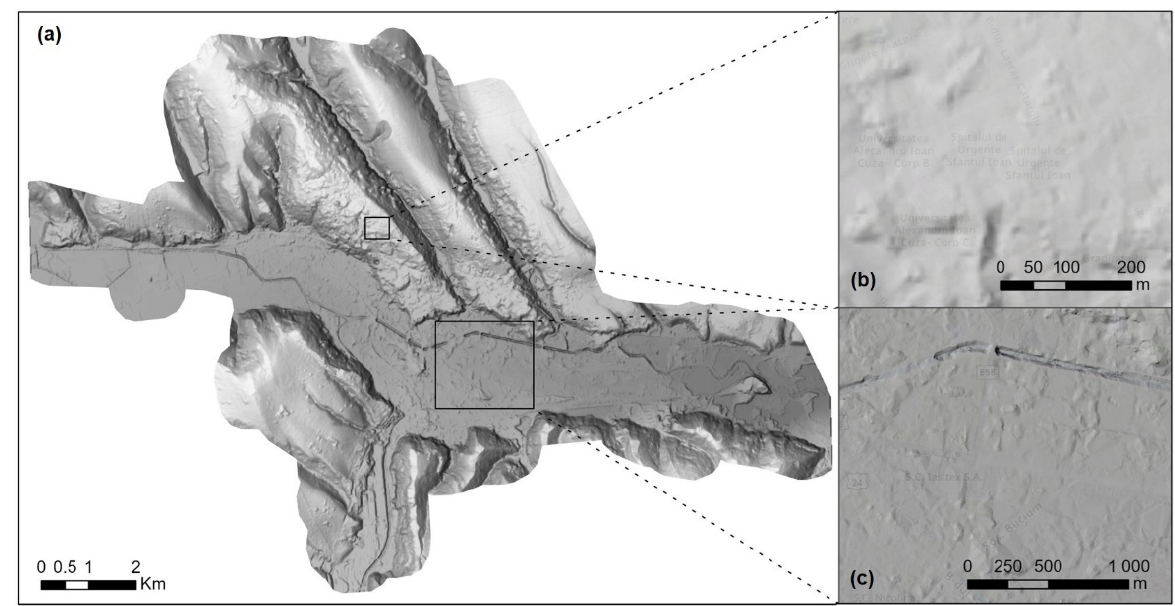
Figure 17. ( a ) Shaded LR ALS-DTM over the Iasi city; ( b , c ) detail view in the city areas.